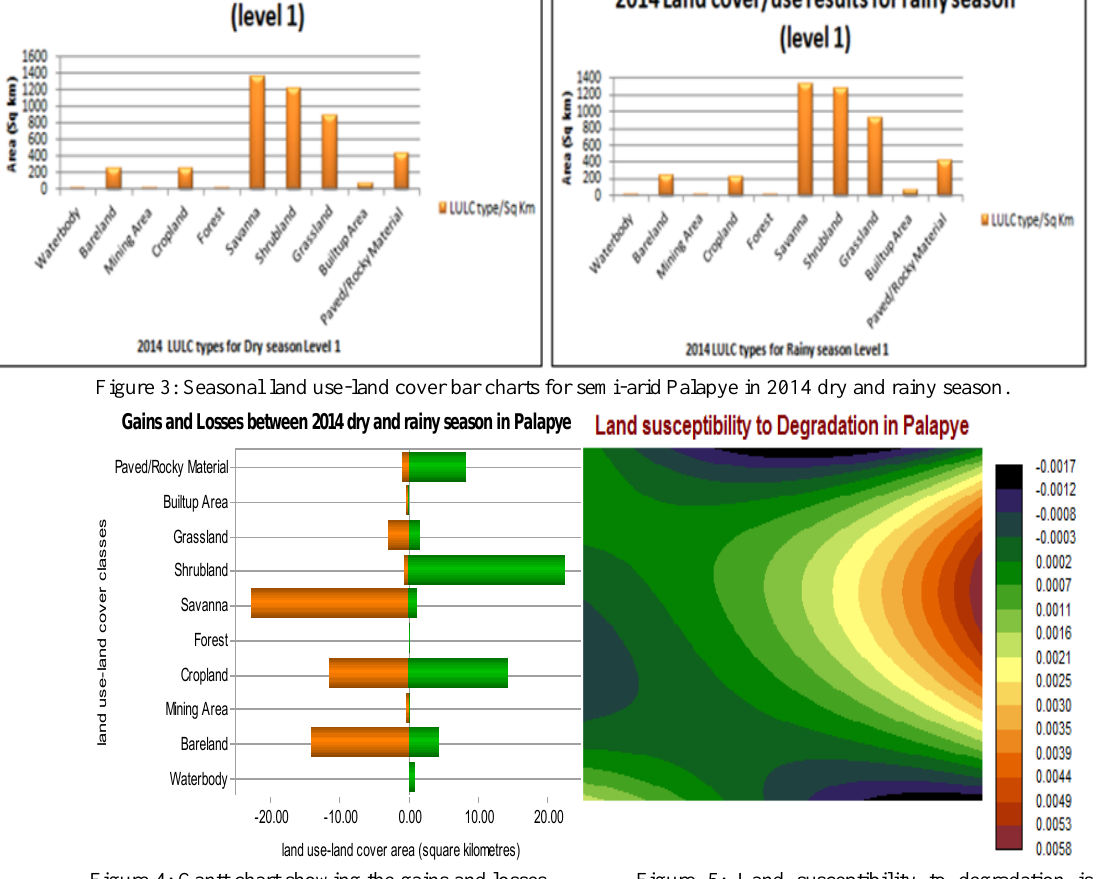
Figure 5: Land susceptibility to degradation is highest in the east of Palapye.